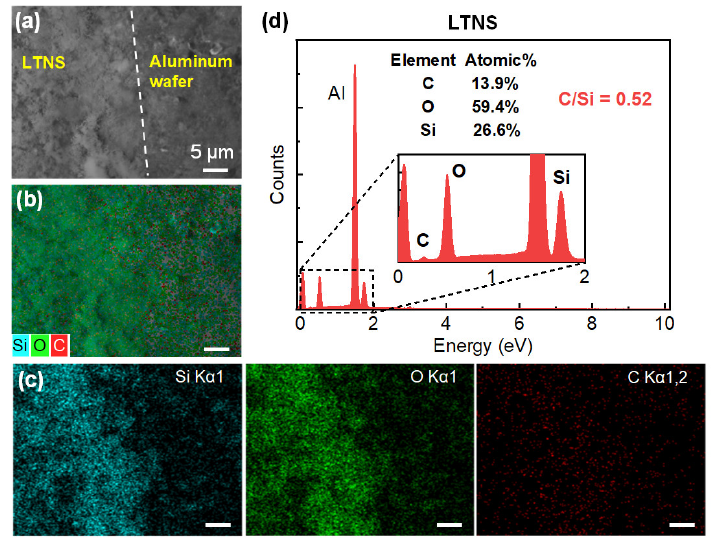
Figure 6. ( a ) SEM image, ( b , c ) elemental mapping analysis, and ( d ) EDX analysis of the LTNS film. The white dash line roughly indicates the boundary between the LTNS film and bare Al wafer. The scale bars in figures ( b , c ) indicate 5 μm.